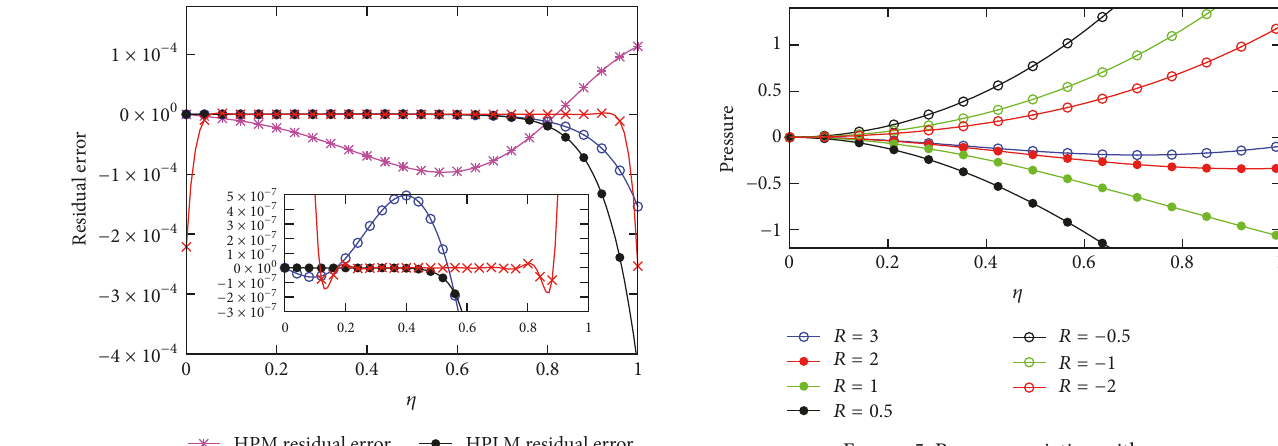
Figure 5: Pressure variation with 𝜂 .